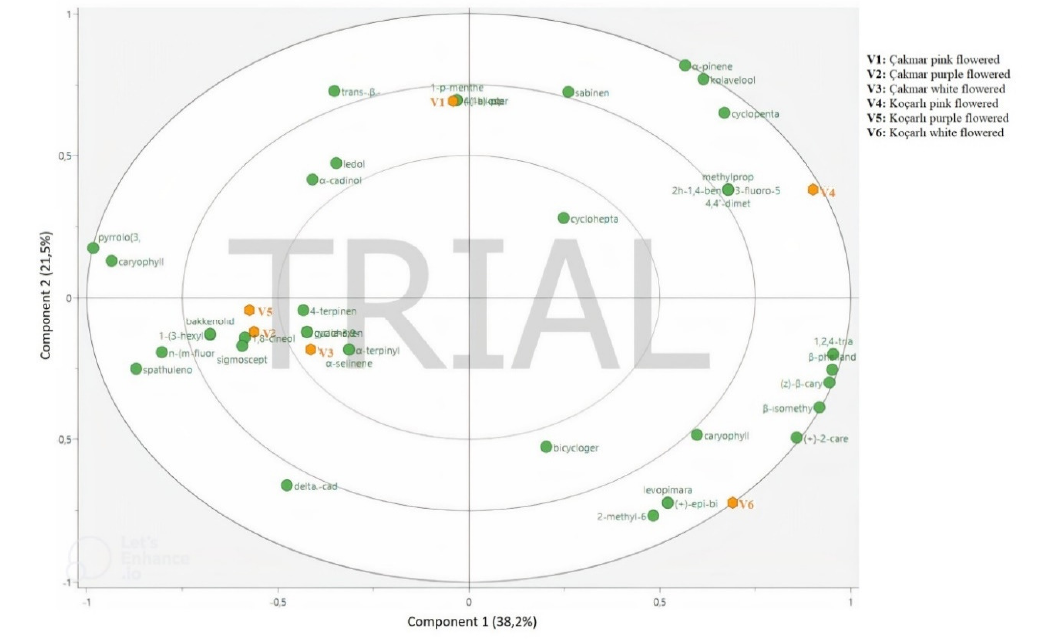
Figure 7. Biplot of the first two principal